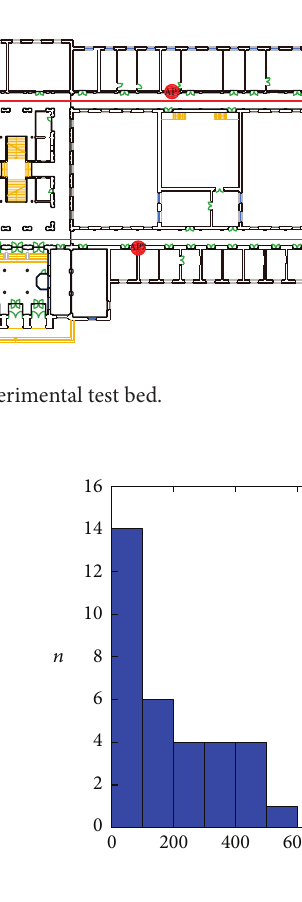
Figure 2: Histogram of the positioning error for NN algorithm without optimization.